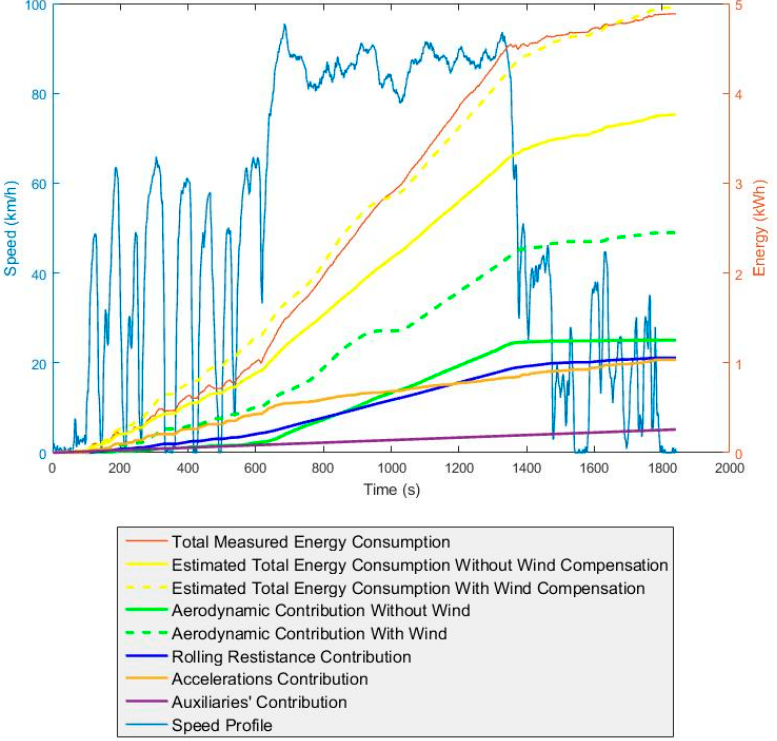
Figure 3. Depicts the speed profile, cumulative energy measured, the cumulative energy and